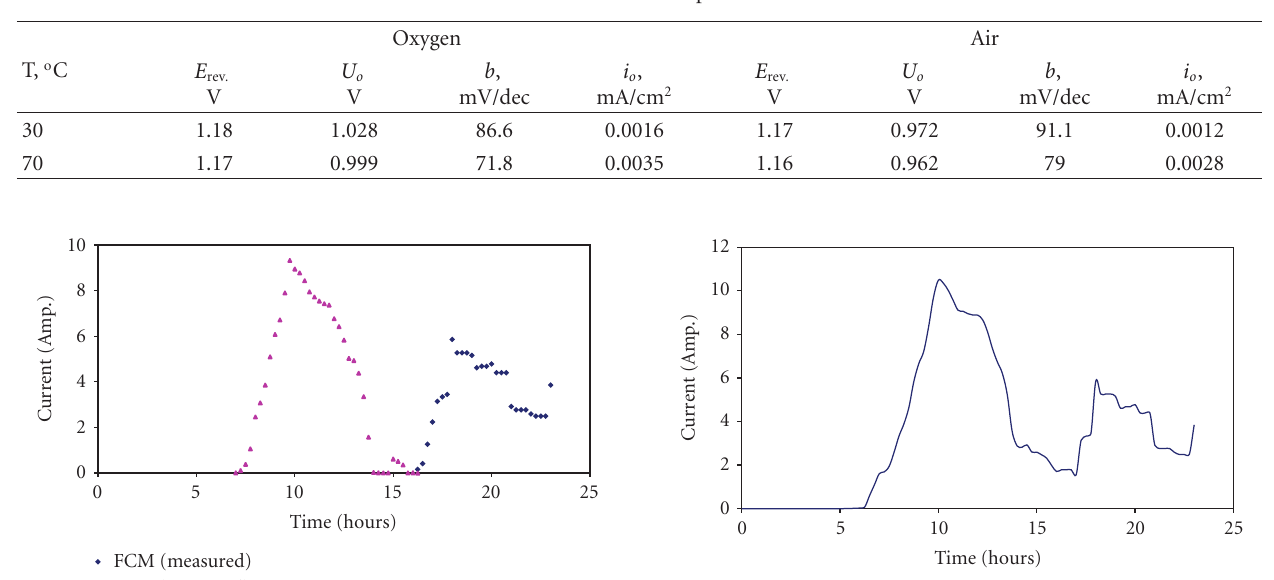
Table 2: Fuel cell mode parameters.